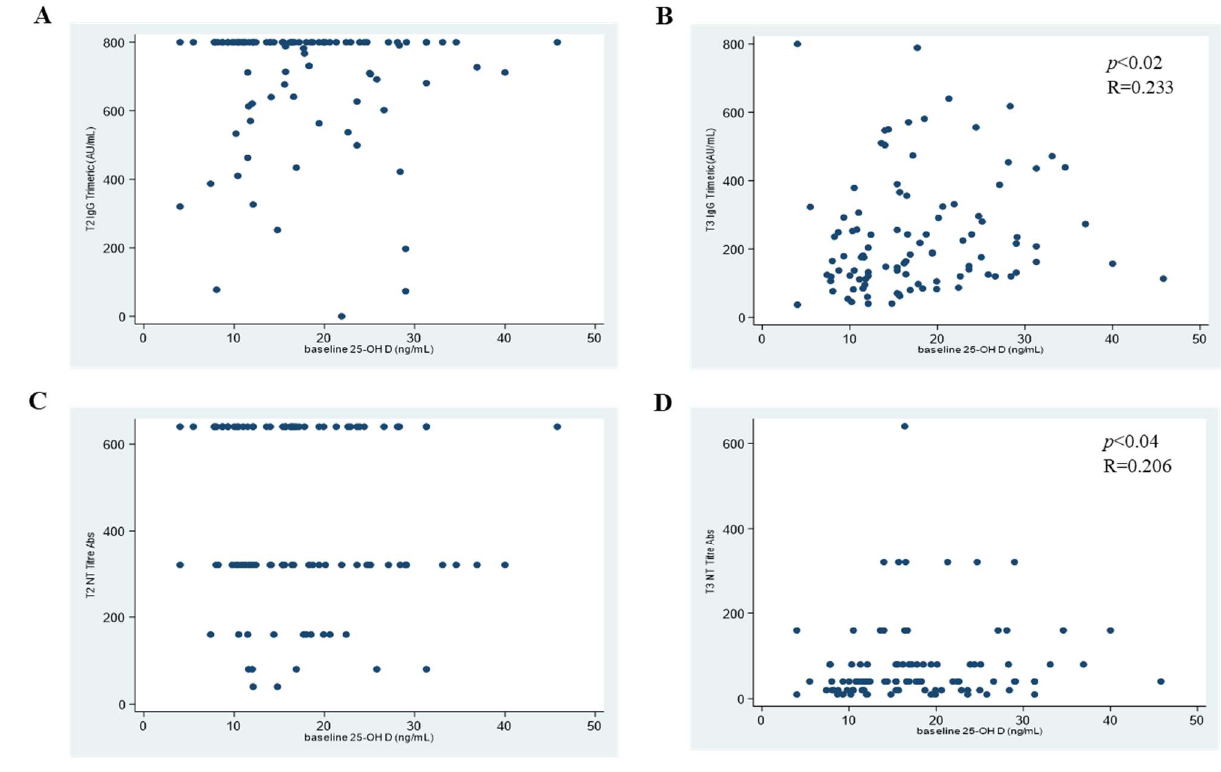
Figure 2. Correlation between 25OHD concentration at baseline and anti-S response at T2 ( A ) and T3 ( B ); 25OHD concentration vs. NT titre at T2 ( C ) and T3 ( D ).